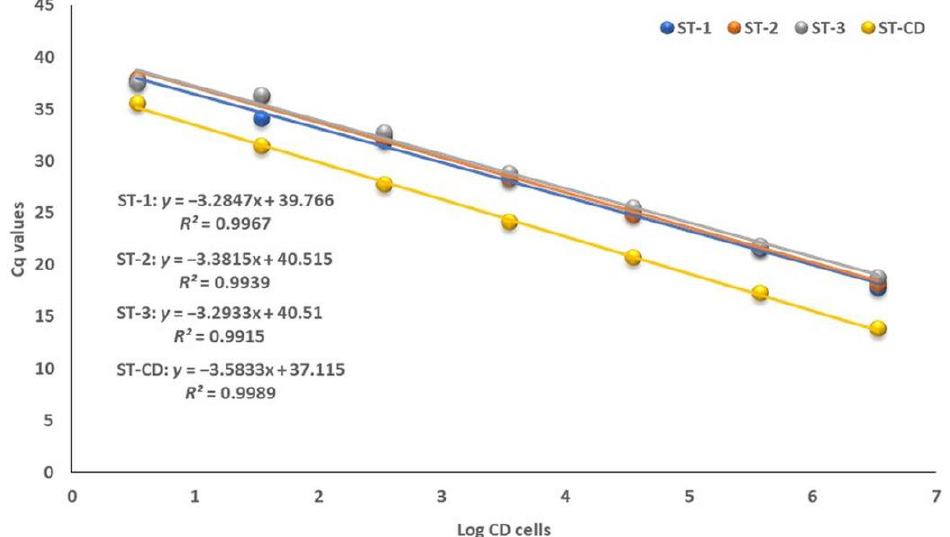
Figure 1. Amplification efficiencies of standards of pure culture of C. difficile DSM 1296 (ST-CD) and triplicate assays of CD-spiked feces (ST-1, ST-2, and ST-3).